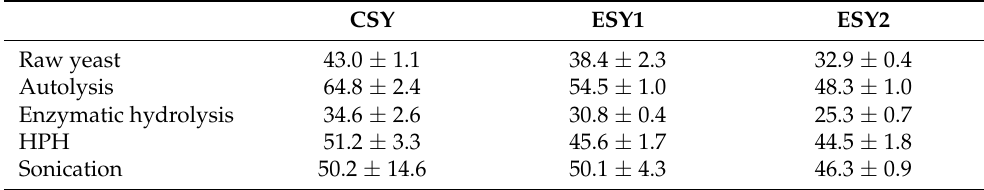
Table 1. Protein content (% w / w ) of raw yeast and extracts obtained from each extraction process applied to different yeast strains (CSY, ESY1 and